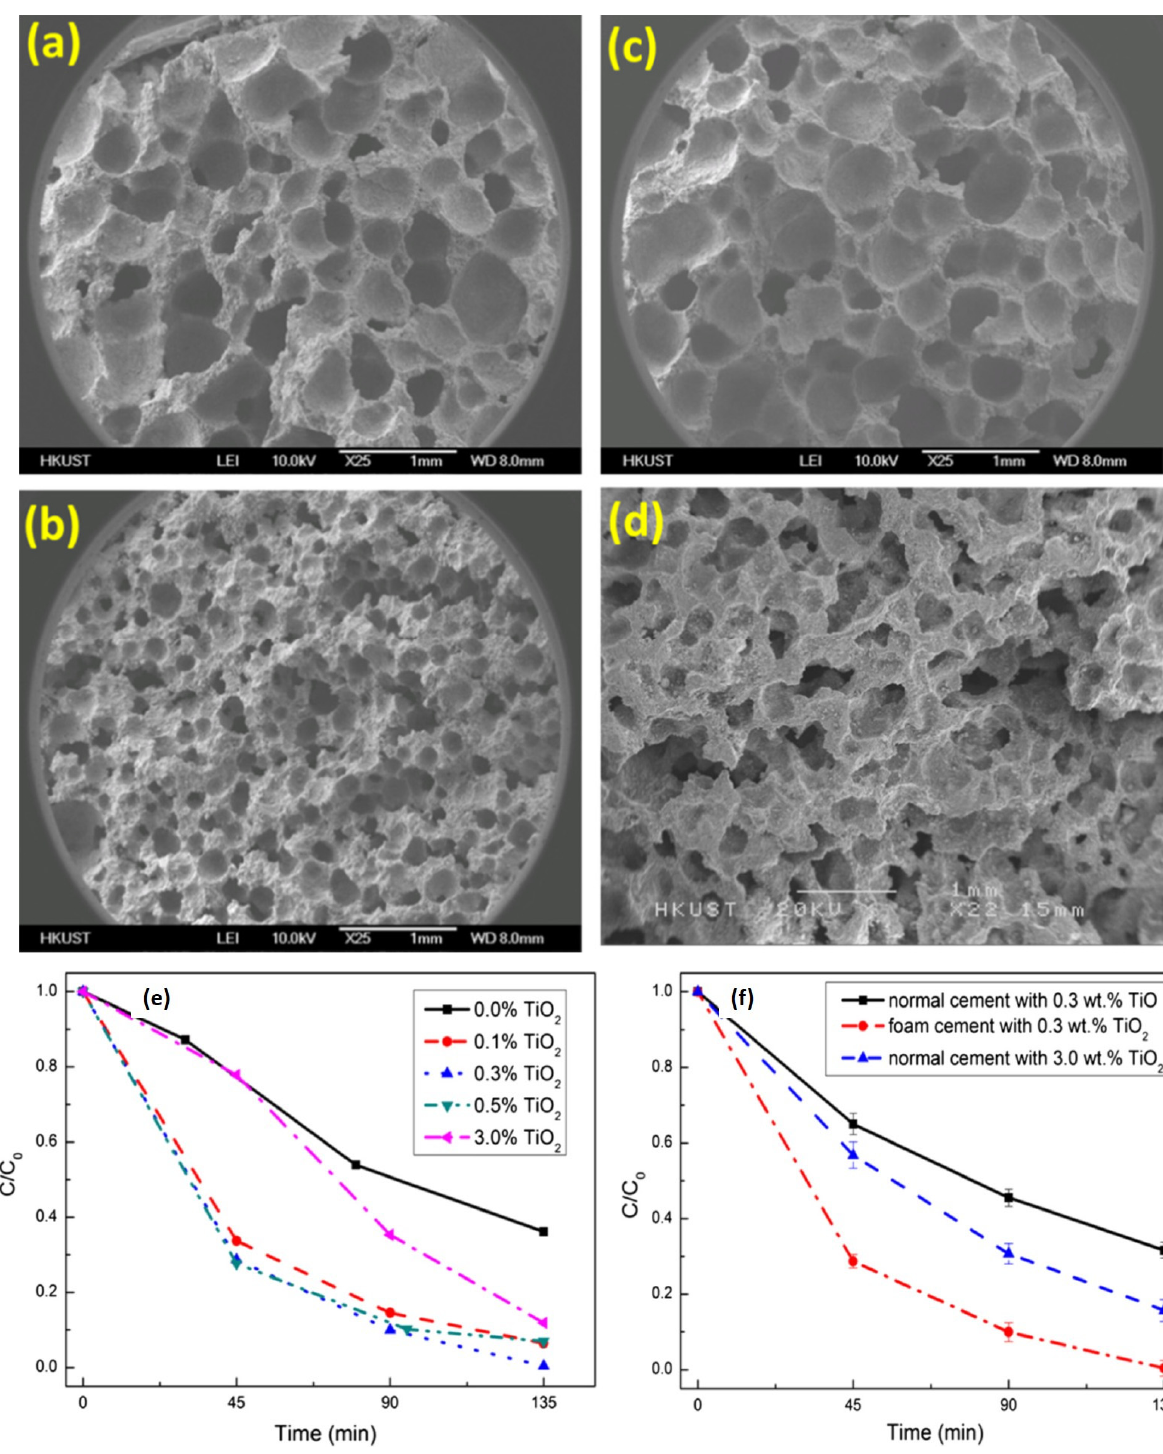
Figure 5. SEM micrographs of porous cement with TiO 2 of ( a ) 0.1 wt.%; ( b ) 0.3 wt.%; ( c ) 3.0 wt.%; ( d ) microstructure of the 0.3 wt.% TiO 2 modified foam cement; photodegradation of MB ( e ) foam cement with different amounts of TiO 2 ; ( f ) normal/foam cement with 0.3 wt.% TiO 2 and normal cement with 3.0 wt.% TiO 2 . Ref. [42].